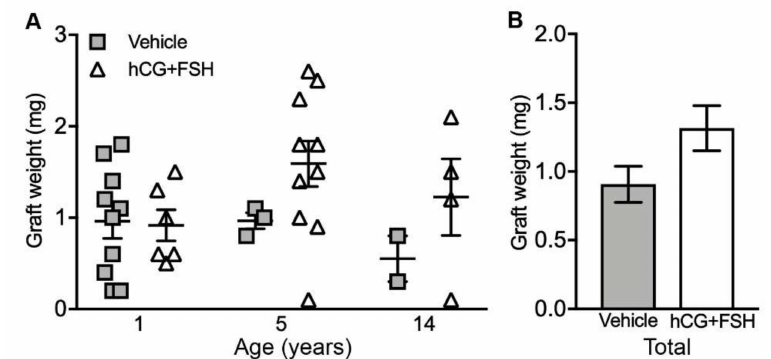
Figure 1. Graft weights from the castrate recipient mice exposed to either vehicle or gonadotrophins (hCG + FSH). ( A ) Individual data points represent the weight of a single subcutaneous xenograft, n = 15–20 grafts per group; p = 0.113. ( B ) Graph shows overall mean data. Statistical significance was determined using two-way ANOVA. Data are presented as mean ±